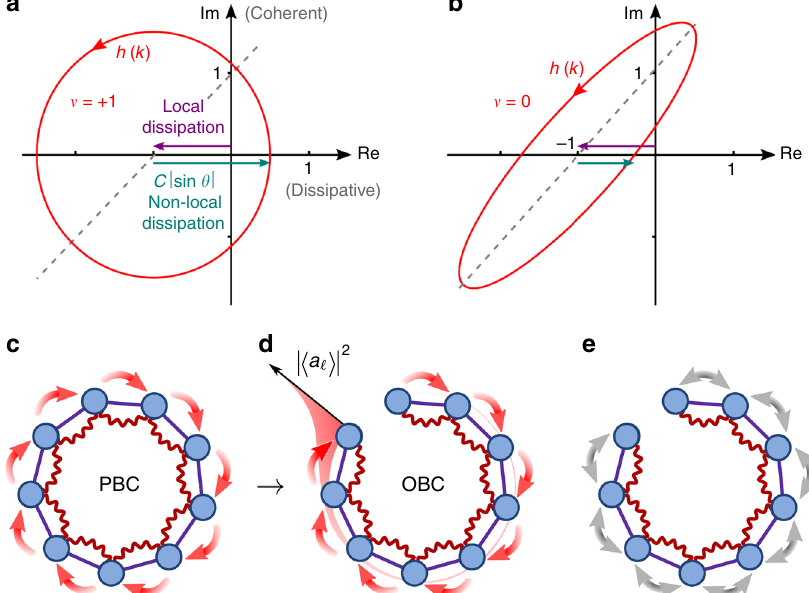
Fig. 2 Topological invariant for the dynamic matrix, and intuitive explanation for the gain. Under PBC, the eigenvalues of the dynamic matrix M ( ω ), Eq. (7), describe a closed curve h ( k ) (red) in the complex plane — the generating function (10). This allows us to de fi ne the winding number ν of Eq. (11) counting the revolutions of h ( k ) around the origin. a On resonance, ω = 0, the non-local dissipation has to surpass the local dissipation to yield a non-trivial winding number, see Eq. (14). Otherwise, b ν is trivial. This competition between local and non-local contributions in the generating function is indicated by the purple and blue arrows. For θ = 0 or π , h ( k ) degenerates into a line, which is shown for θ = 0 in a and b as dashed lines. When θ = π the slope changes sign. In a θ ¼ π and in b θ = 0.5. c Under PBC with ν ≠ 0, excitations travel directionally around the ring and gain energy at each revolution causing 2 instability. d Removing one link (OBC) leads to the accumulation of excitations at one end, which determines the end-to-end gain. e For reciprocal dynamics, removing the link only induces local changes and no